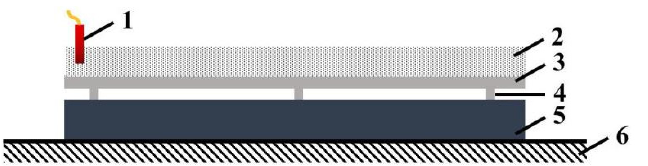
Figure 1. A scheme of explosive welding: 1. detonator; 2. explosives; 3. Ti plate; 4. spacer; 5. carbon steel plate; and 6. anvil.